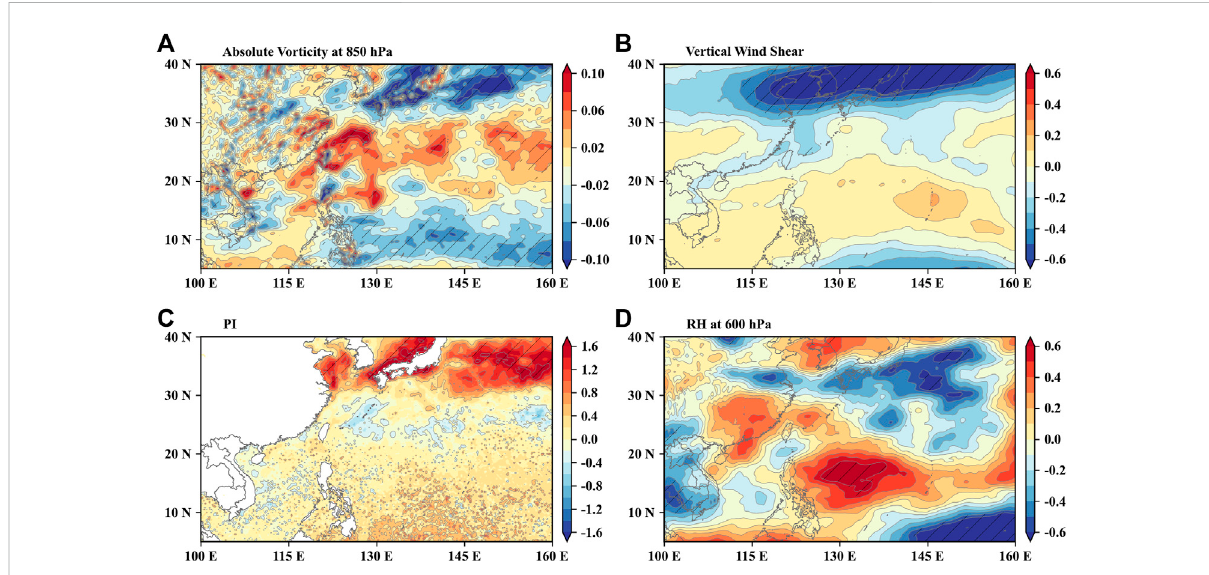
FIGURE 8 Regression of environmental factors with respect to the mean TCs genesis latitudes during 1980 – 2020. (A) Absolute vorticity at 850 hPa (10 – 5 s − 1 per latitudinal degree), (B) VWS (m s − 1 per latitudinal degree), (C) PI (m s − 1 per latitudinal degree), and (D) RH at 600 hPa (% per latitudinal degree). The stippling indicates the regression exceeding the 90% con fi dence